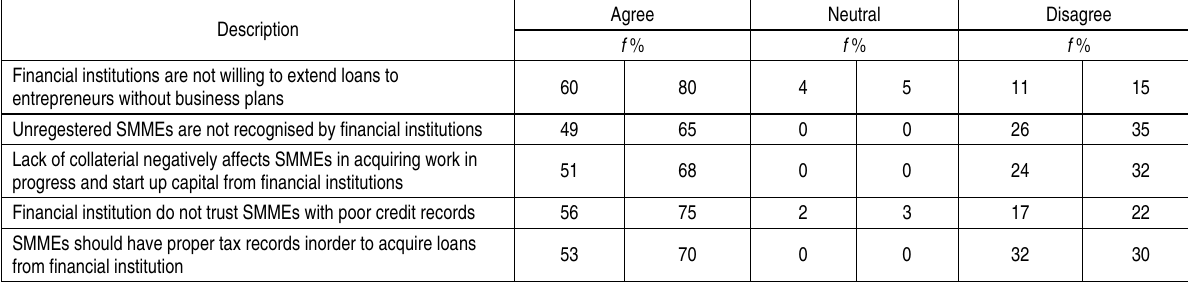
Table 5. Barriers to accessing